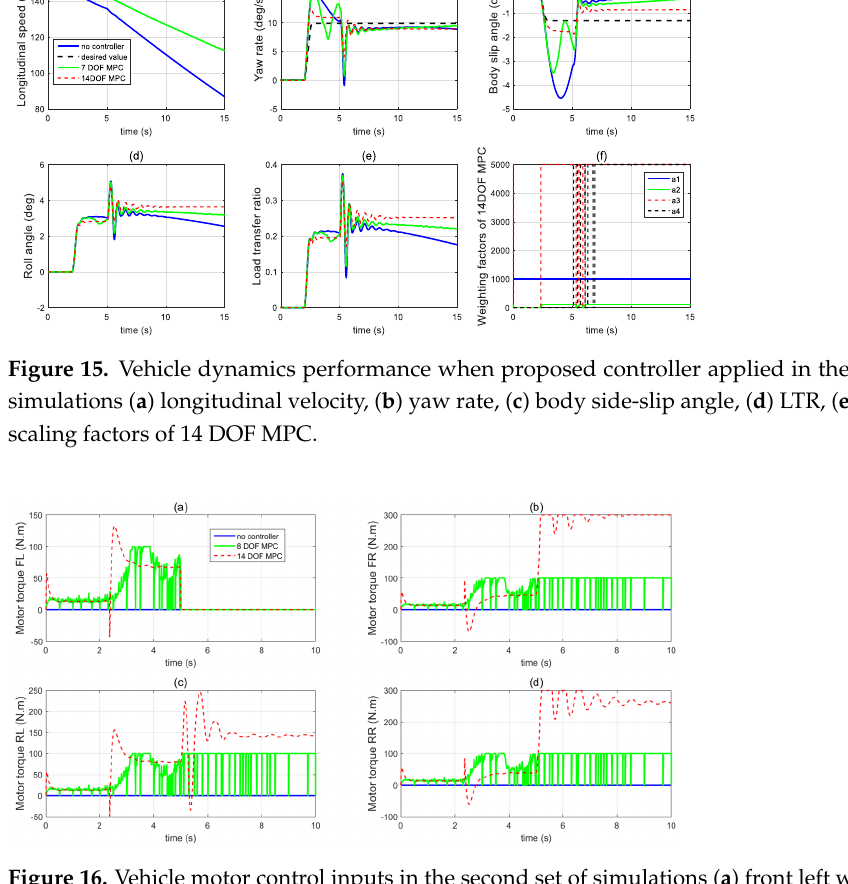
Figure 16. Vehicle motor control inputs in the second set of simulations ( a ) front left wheel, ( b ) front right wheel, ( c ) rear left wheel, ( d ) rear right wheel.